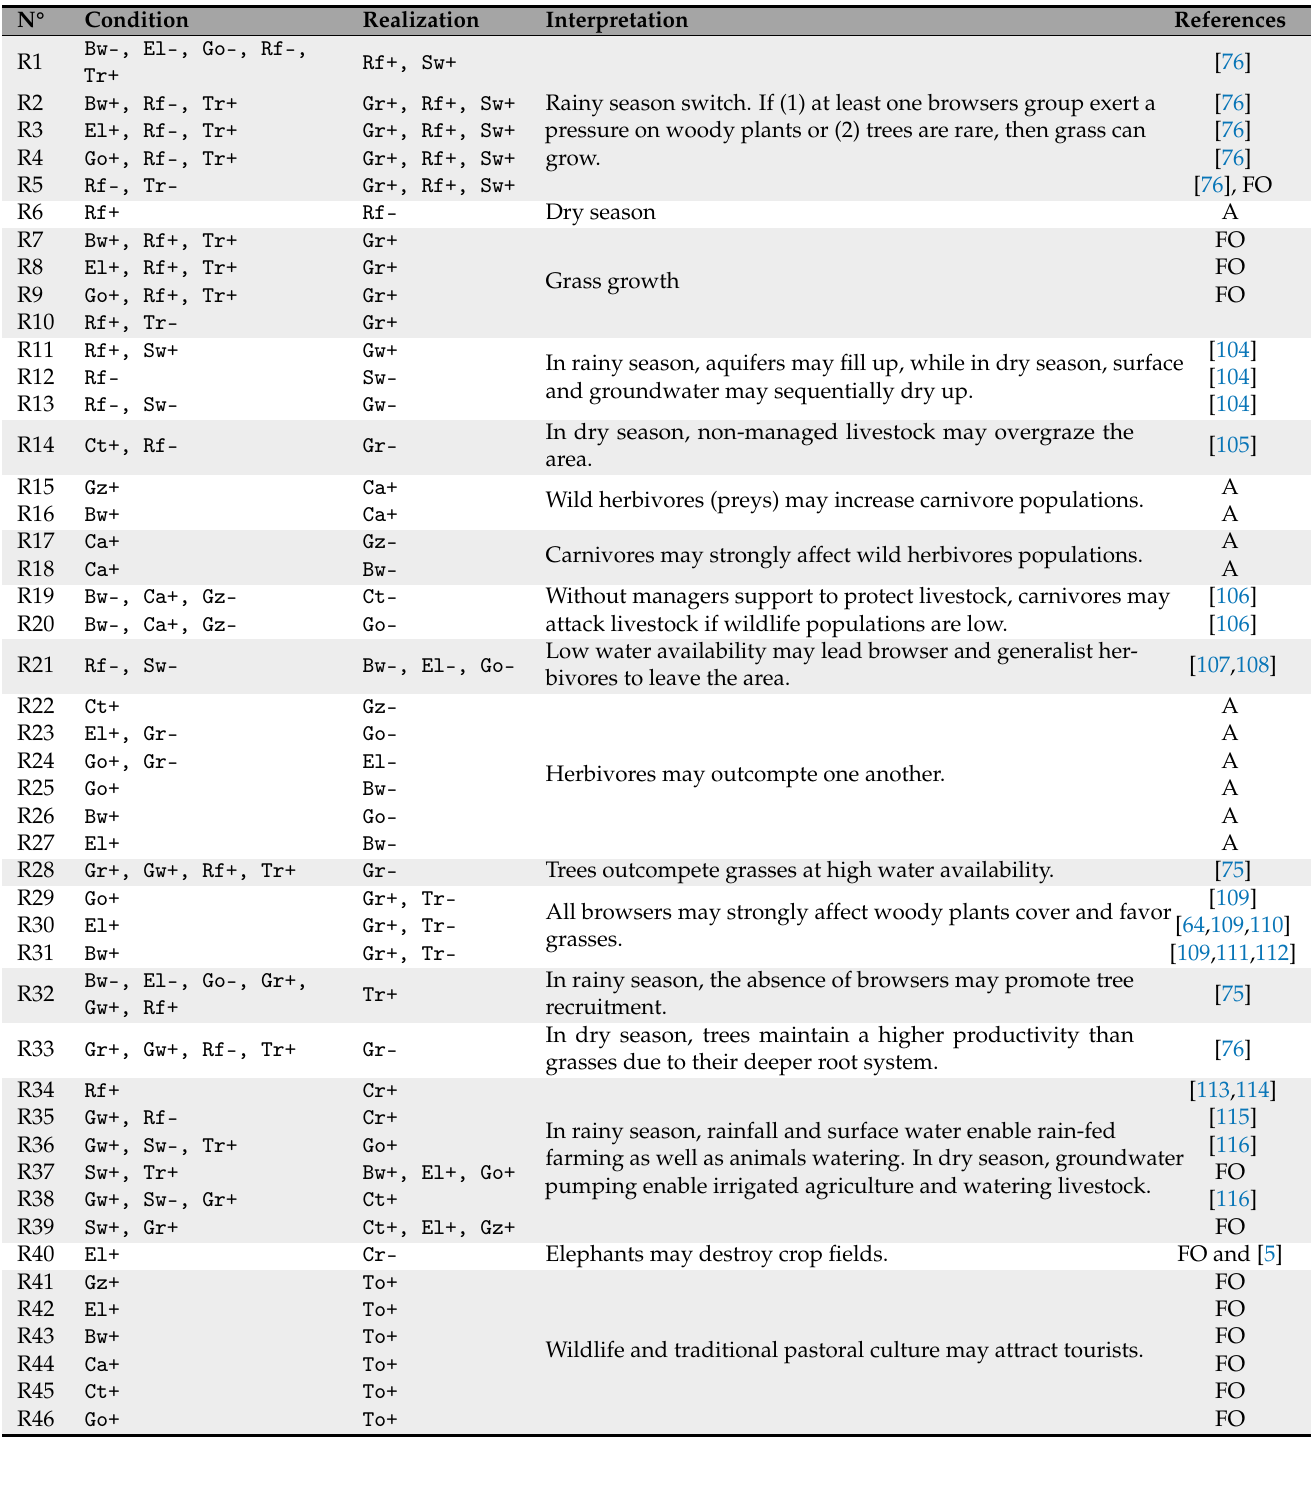
Table A2. Model rules. Rules with similar descriptions are grouped within the same multirow. A: Assumption, FO: Field observation or report from